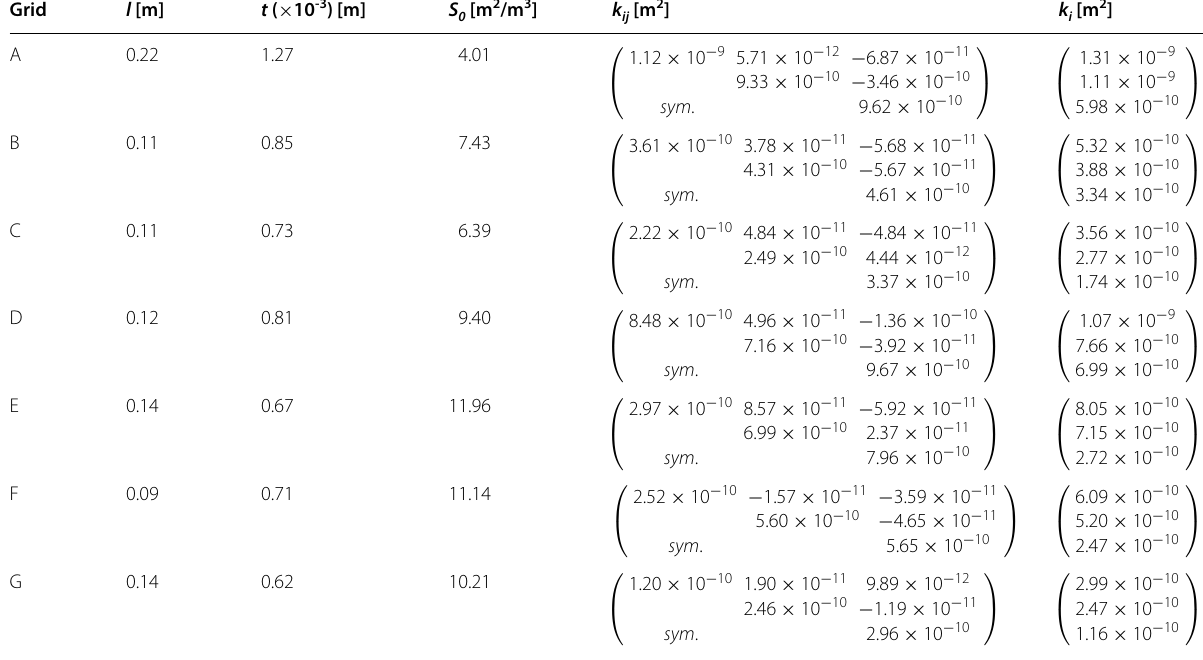
Here, k i is the principal permeability of k ij